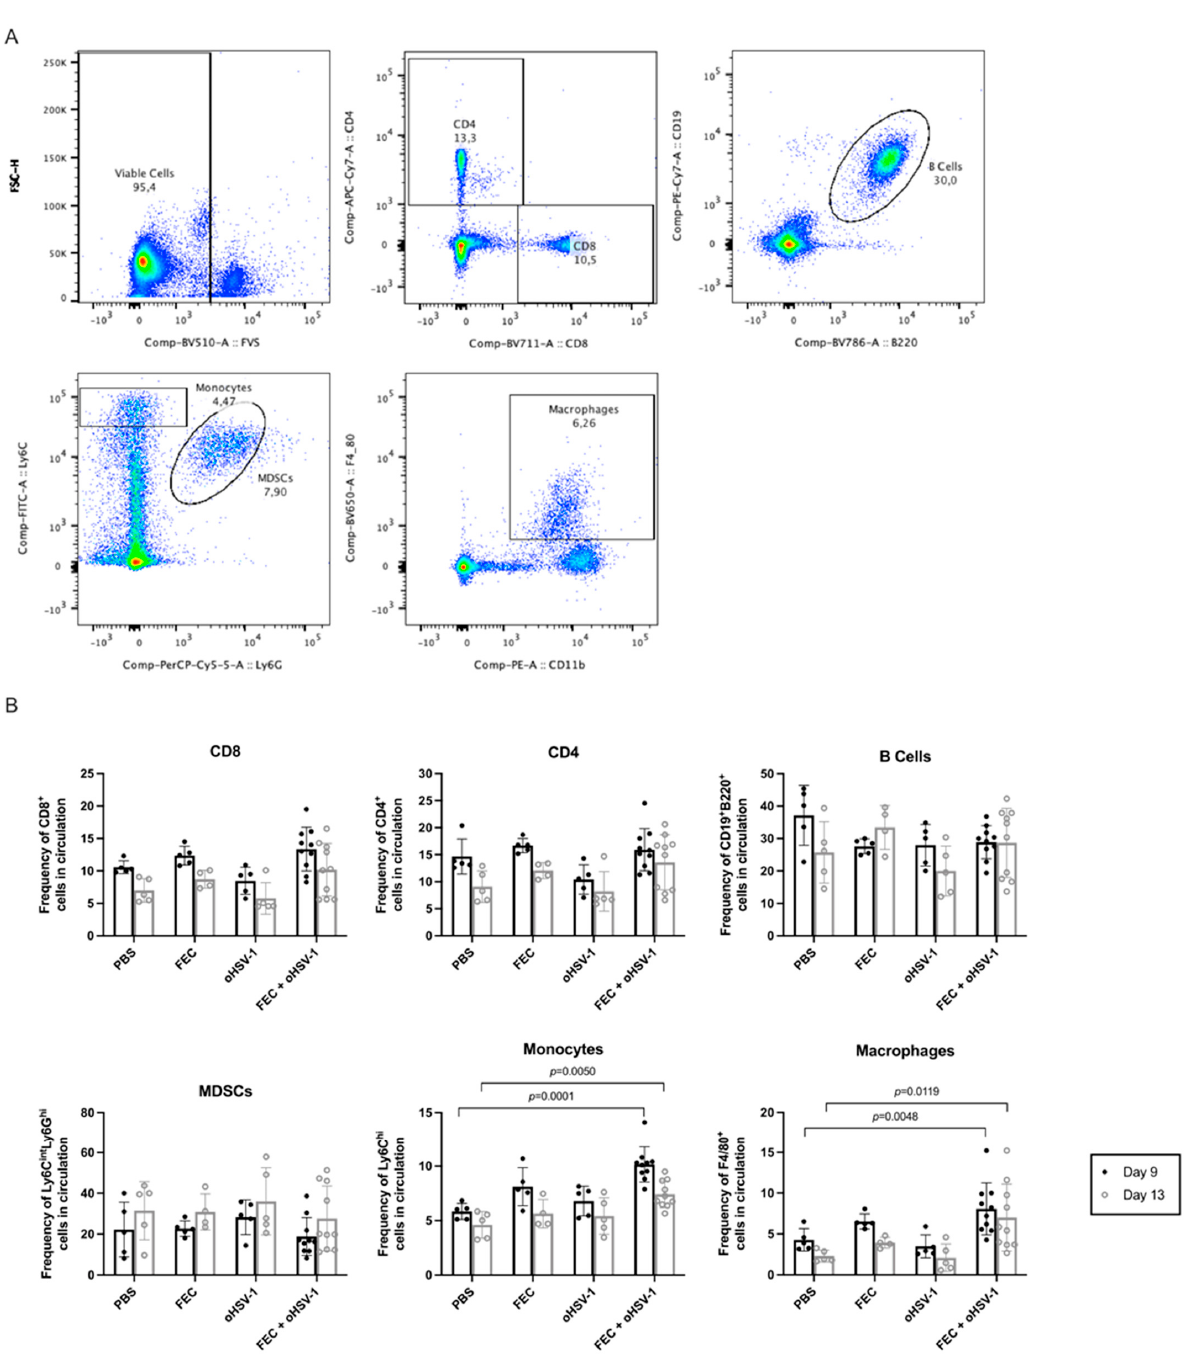
Figure 4. FEC + oHSV-1 therapy increases monocytes and macrophages in the peripheral blood. C57/Bl6 mice bearing E0771 subcutaneous tumors were treated with either PBS ( n = 5), FEC ( n = 5), oHSV-1 ( n = 5), or FEC + oHSV-1 ( n = 10). Blood was taken 9 and 13 days after the start of treatment and was analyzed via flow cytometry. ( A ) Representative flow plots showing the gating strategy for each immune cell type. ( B ) Bar plots showing the frequencies of T cells (CD8 + and CD4 + ), B cells (CD19 + B220 + ), MDSCs (Ly6C int Ly6G hi ), monocytes (Ly6C hi Ly6G − ), and macrophages (F4/80 + ) in circulating PBMCs. Dots are representative of individual mice. Error bars are representative of the standard deviation. ANOVA test was used for statistical analyses.